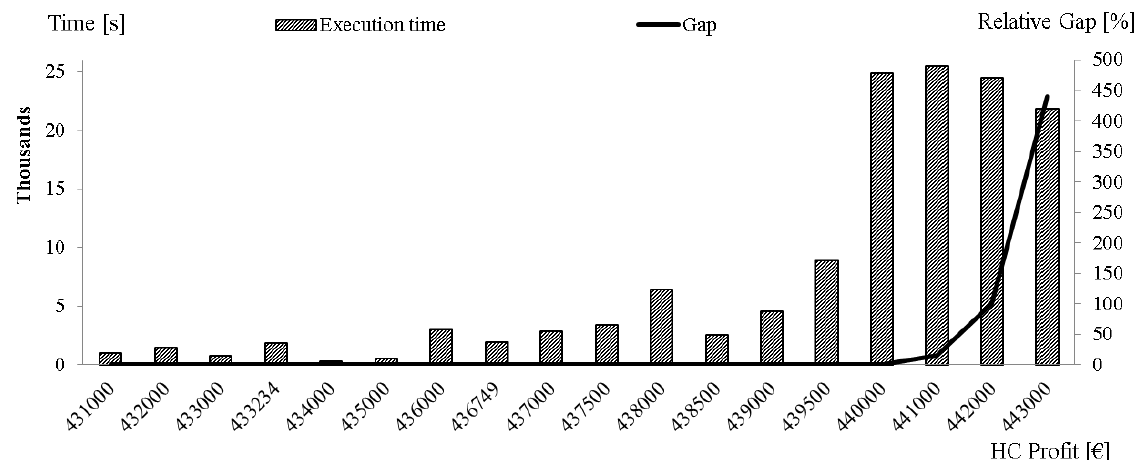
Figure 9. Relative solution gap and execution time.